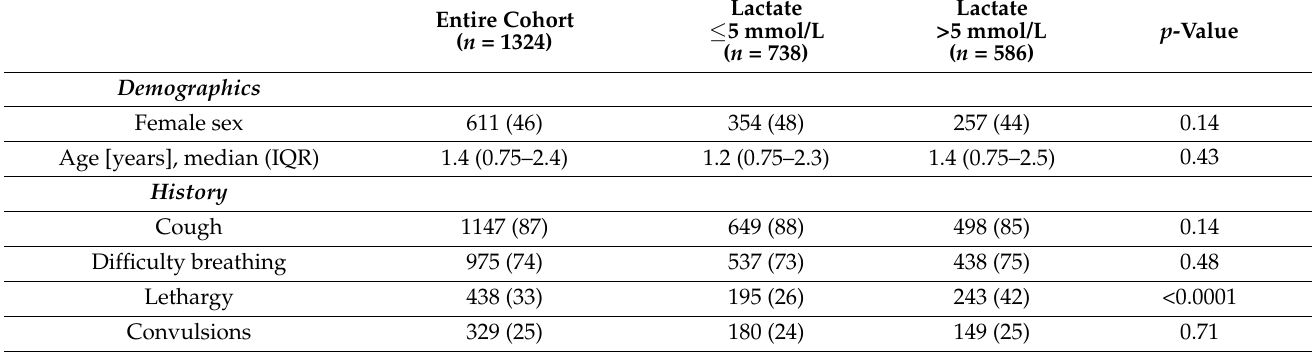
Table 1. Characteristics at hospital admission of 1324 Ugandan children with malaria and respiratory distress, stratified by bedside blood lactate